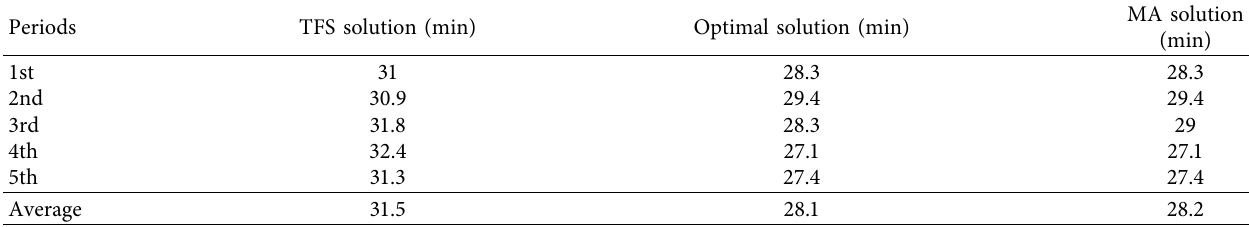
Table 5: Average p for each period of the example simulated. tt